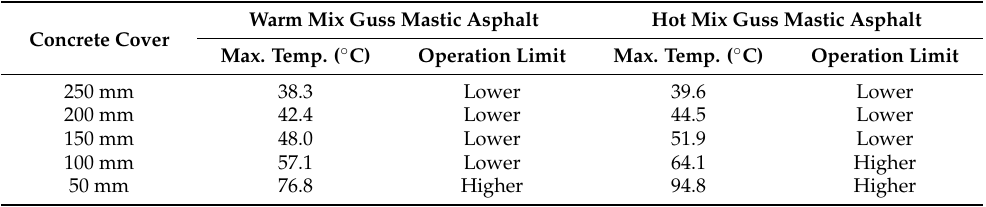
Table 9. FEA results in maximum temperature on the top of the